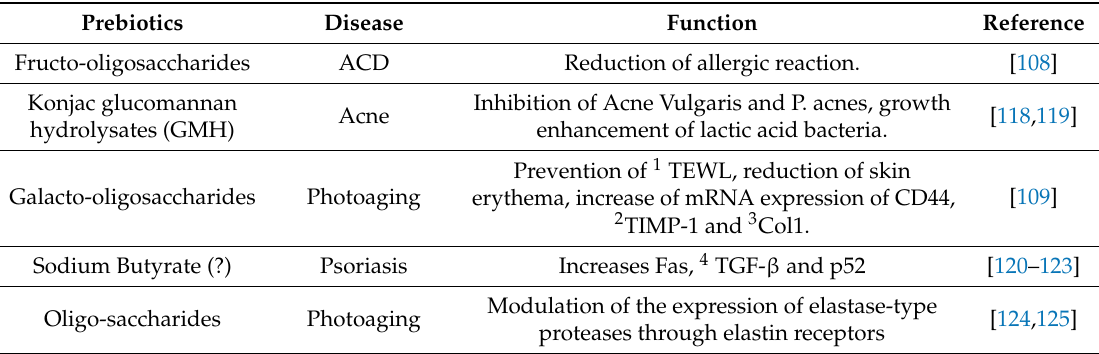
Table 2. Prebiotics and their e ff ect on skin